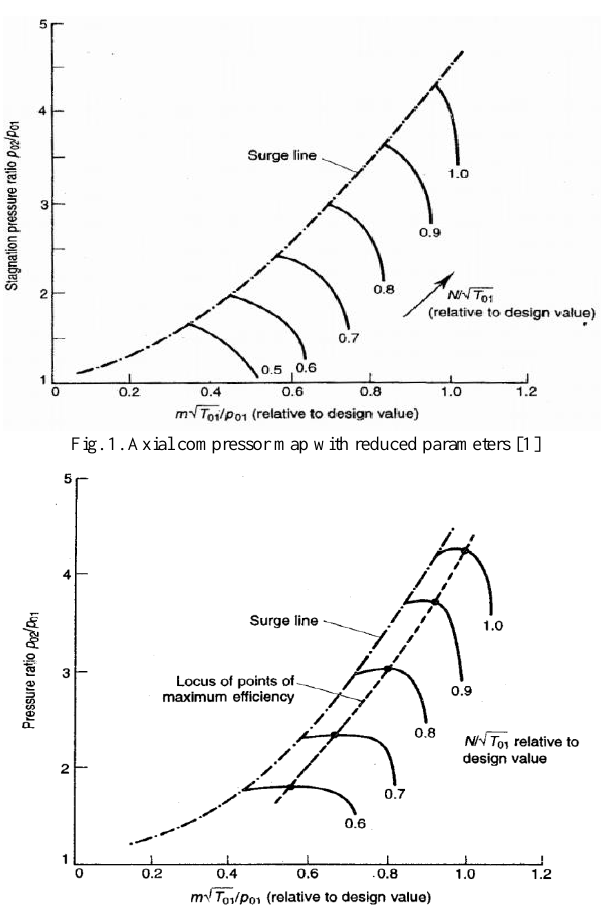
Fig. 2. Centrifugal compressor map with reduced parameters